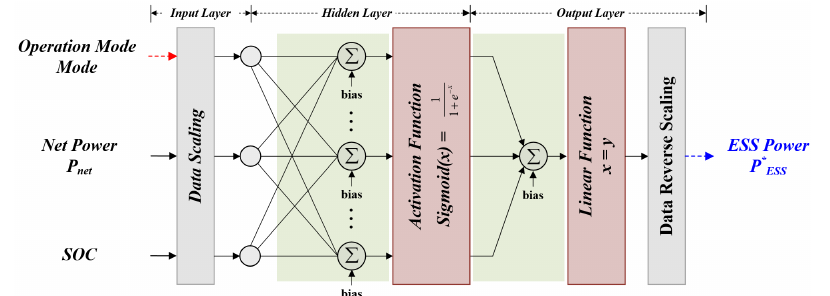
Figure 8. Configuration of second step of ANN structure.